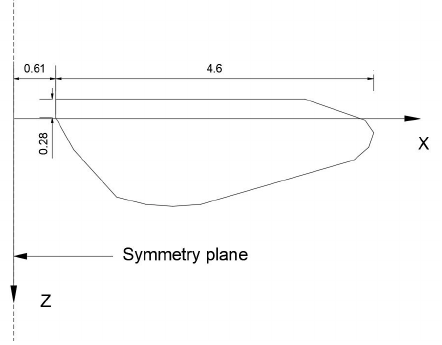
Figure 2. Simplified geometric model of the dragonfly hindwing.